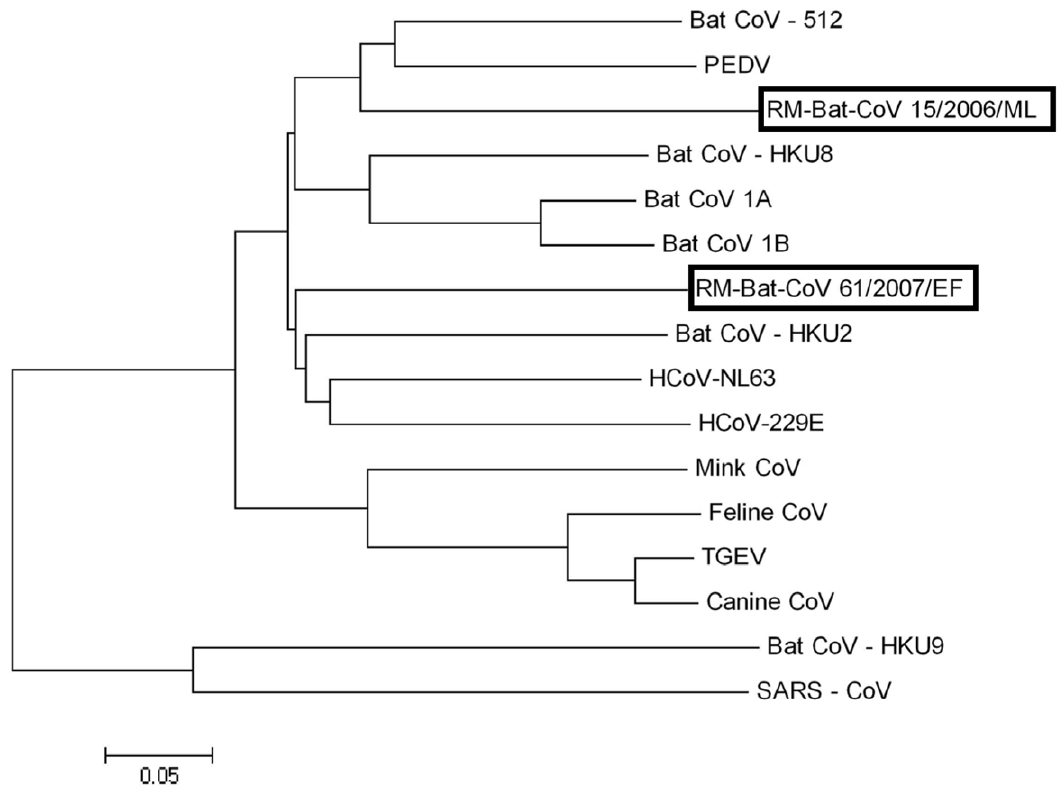
Figure 3. Phylogenetic analysis of the RdRp gene. Phylogenetic analysis of an approximate 4000 nucleotide sequence (2 segments) of the RdRp gene of RM-Bat-CoV-15/2006/ML ( Myotis lucifugus ) and RM-Bat-CoV 61/2007/EF ( Eptesicus fuscus ) compared to other known coronaviruses. Phylogenetic trees were constructed by the neighbor-joining method using MEGA version 4.